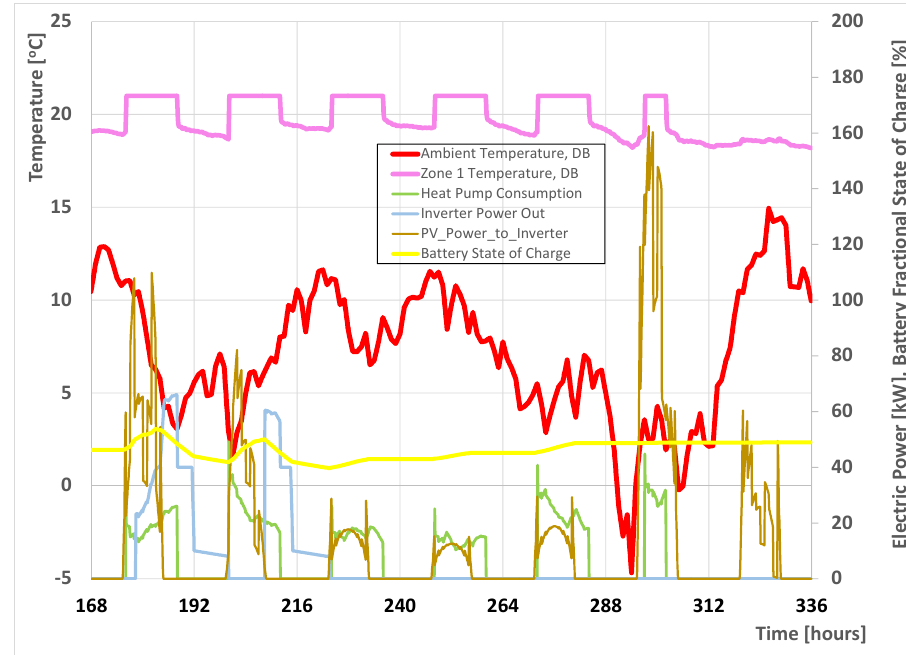
Figure 8. Ambient temperature, room temperature, heat pump electricity consumption, and PV inverter out power in the second week of January. The batteries have reached 50% of their total aggregate capacity and start to discharge during Monday and Tuesday, to cover the building’s loads and electric cars’ consumption. During Wednseday to Friday, the little available PV electricity is employed with first priority to charge the batteries, until they reach 50%